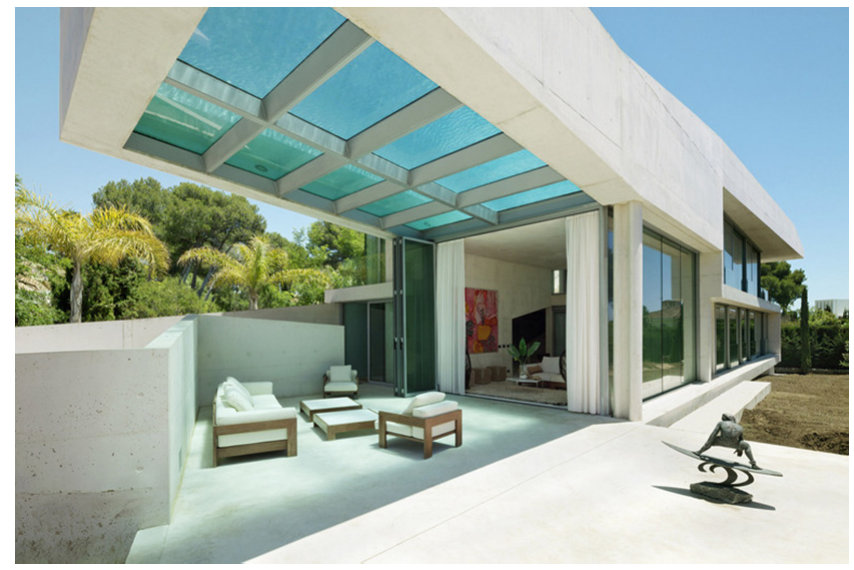
Fig. 1 Jellyfish House